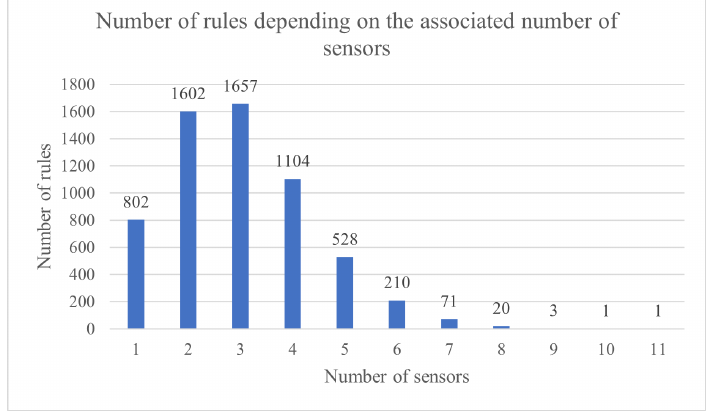
Figure 6. Number of rules depending on the associated number of sensors.